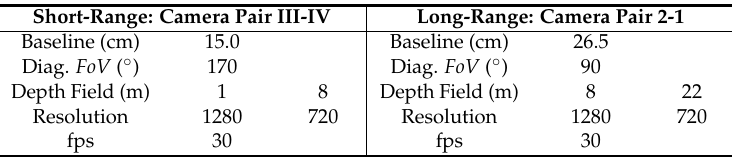
Table 1. Specification of the stereo rigs and constitutive